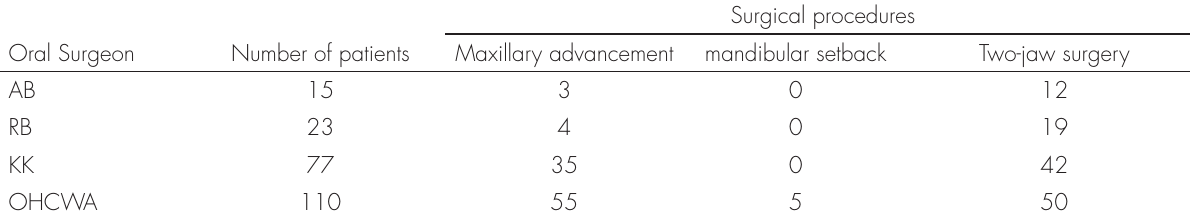
Table III. Number of surgical procedures performed by each surgeon 1985 to